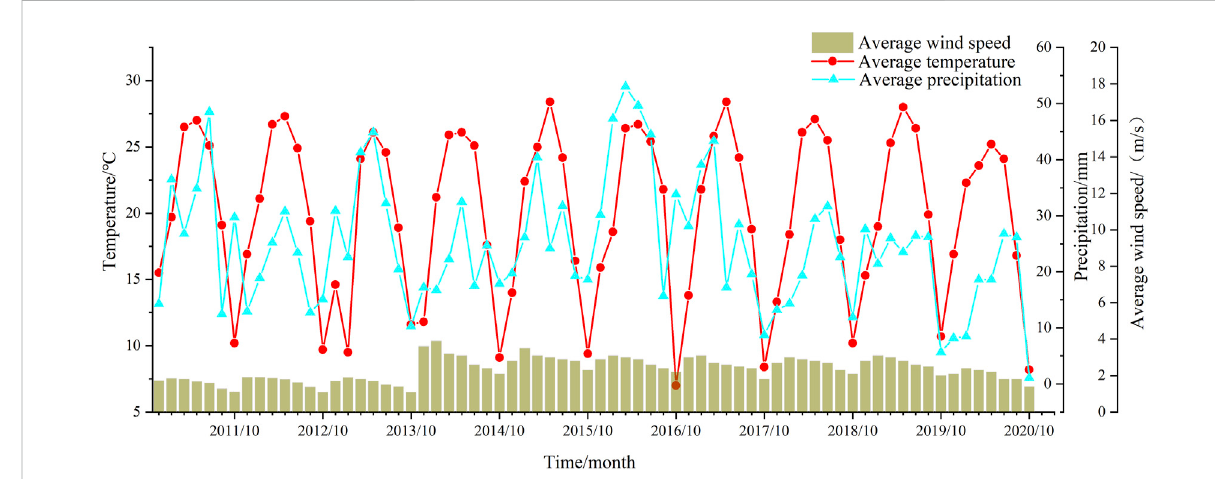
FIGURE 5 Temperature and wind speed results for Jinghe meteorological station.